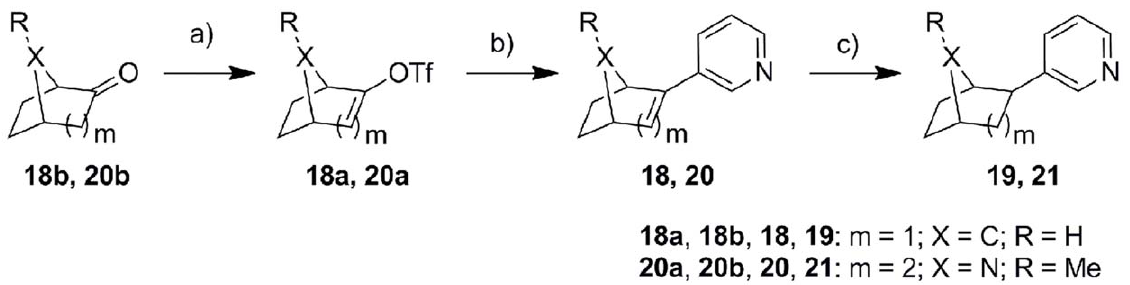
Figure 7. Reagents and conditions. a) Method A: Tf 2 O, CH 2 Cl 2 , 2,6-di-tert-butyl-4-methylpyridine, 2 h; b) Method B: Pd(PPh 3 ) 4 , pyridine-3-boronic acid, Na